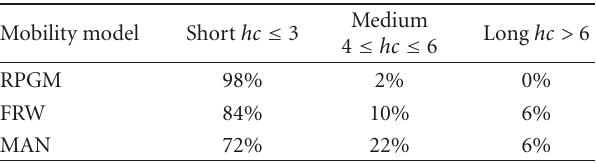
Figure 11: Goodput (Bypass-AODV and AODV). Table 2: The connection hop count distribution (hc); node’s speed is 20 m/sec.